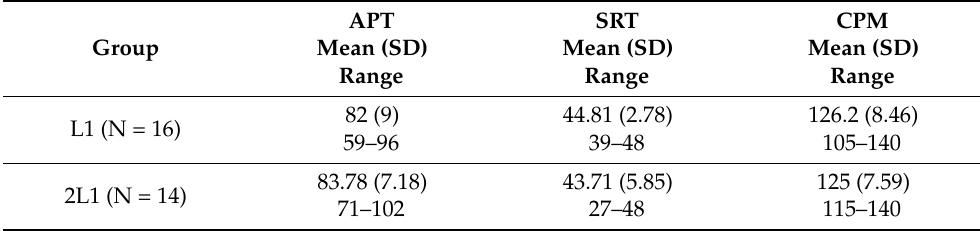
Table 4. Performance of the participants on verbal and non-verbal intelligence tests. APT: Action Picture Test, SRT: Sentence Repetition Task, CPM: Colored Progressive Matrices, SD: standard deviation. In all tests, except for the Sentence Repetition Task, which is not standardized, the standard scores are